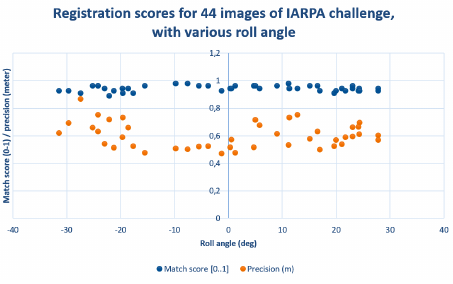
Figure 11. The match rate and the precision score do not depend of the incidence